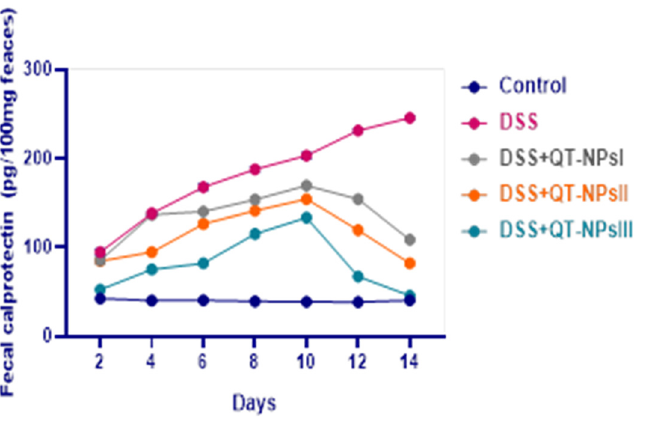
Figure 4. Impacts of quercetin-loaded nanoparticles (QT-NPs) therapy on fecal calprotectin levels post DSS induction. Control: healthy non-colitic group: (rats orally gavaged with PBS); Colitic groups: DSS (rats orally gavaged with dextran sodium sulphate), DSS + QT-NPsI (rats orally gavaged with DSS and quercetin-loaded nanoparticles (QT-NPs at the level 10 mg/kg body weight for 14 days)), DSS + QT-NPsII (rats orally gavaged with DSS and quercetin-loaded nanoparticles (QT-NPs at the level 15 mg/kg body weight for 14 days)), and DSS + QT-NPsIII (rats orally gavaged with DSS and quercetin-loaded nanoparticles (QT-NPs at the level 20 mg/kg body weight for 14 days)). All groups orally gavaged by 3% DSS.